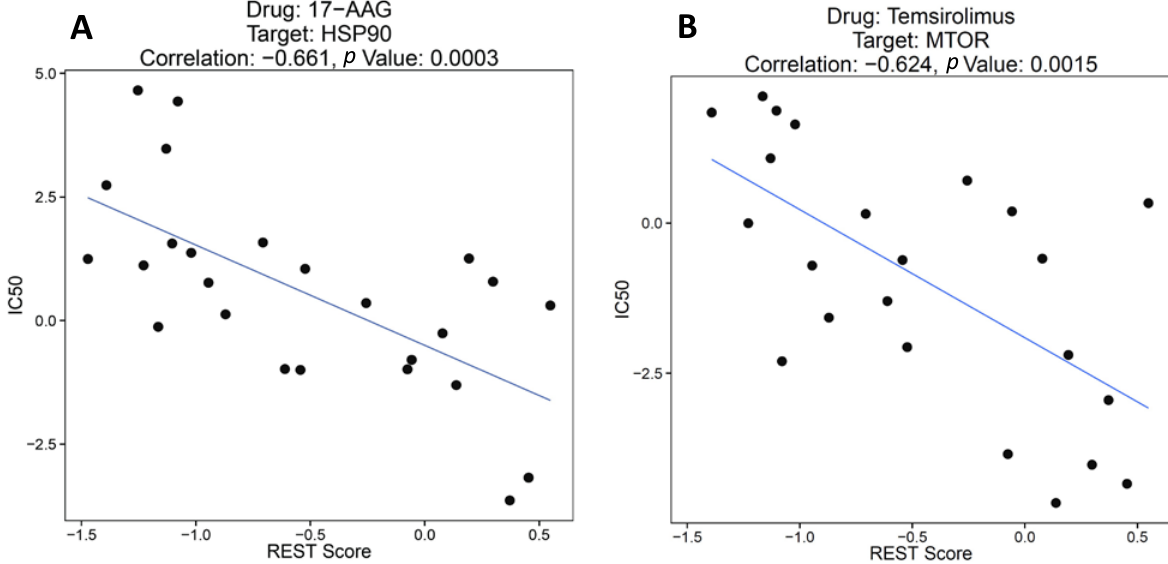
Figure 3. REST signature was used to stratify neuroblastoma cell lines into chemo-sensitive and chemo-resistant groups. ( A , B ) Cell lines with higher REST scores were more sensitive to 17-AAG and Temsirolimus treatment; ( C , D ) Cell lines with lower REST scores were more sensitive to ABT.263 and Sunitinib